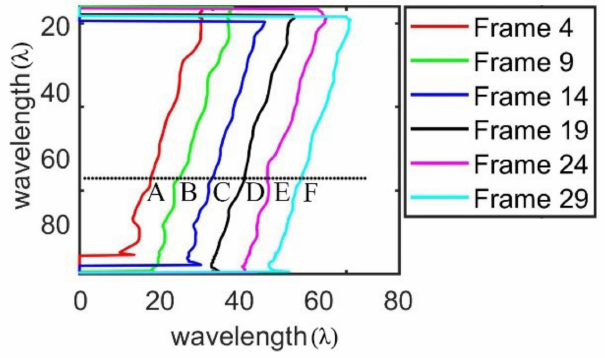
Figure 3. Tracing curves of shear wave propagation trajectories with different